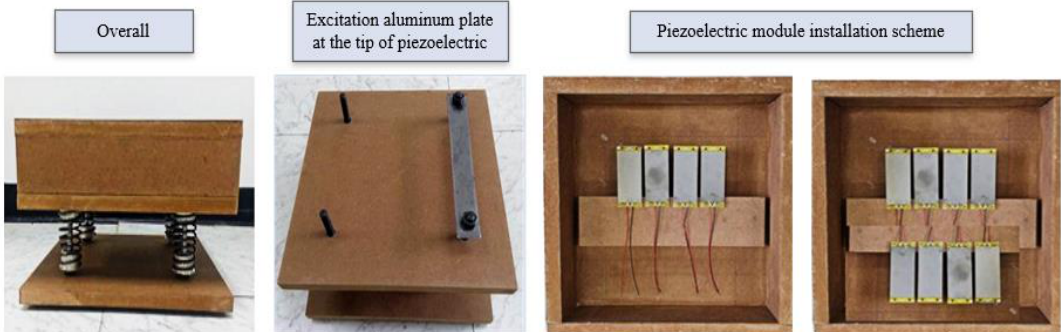
Figure 6. Preliminary test kit using springs for the enhancement of the vibration energy.